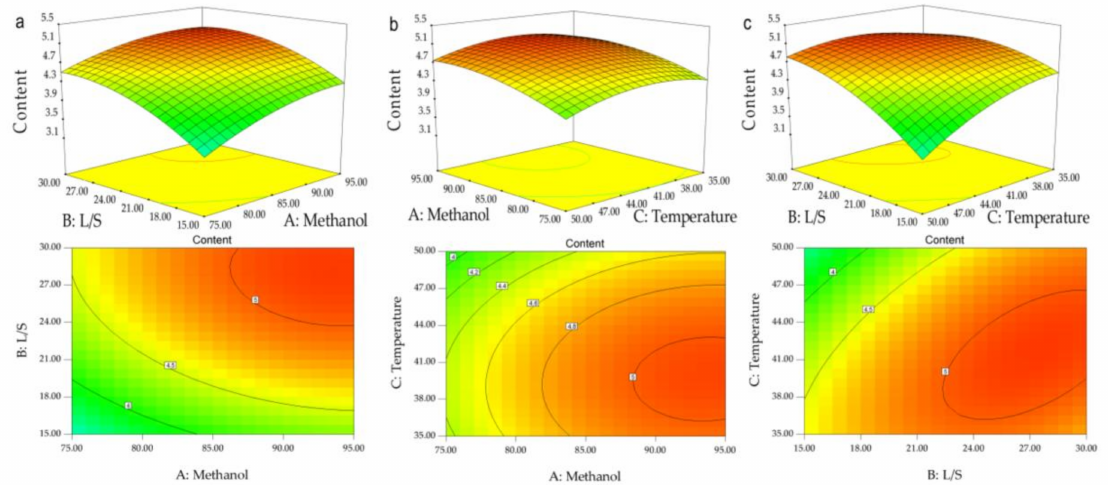
Figure 2. Response surface plots of the effect of factor interactions on gigantol extraction yield. ( a ) Effect of the interaction between methanol concentration and the liquid ratio; ( b ) Effect of the interaction between methanol concentration and temperature; ( c ) Effect of the interaction between temperature and the liquid